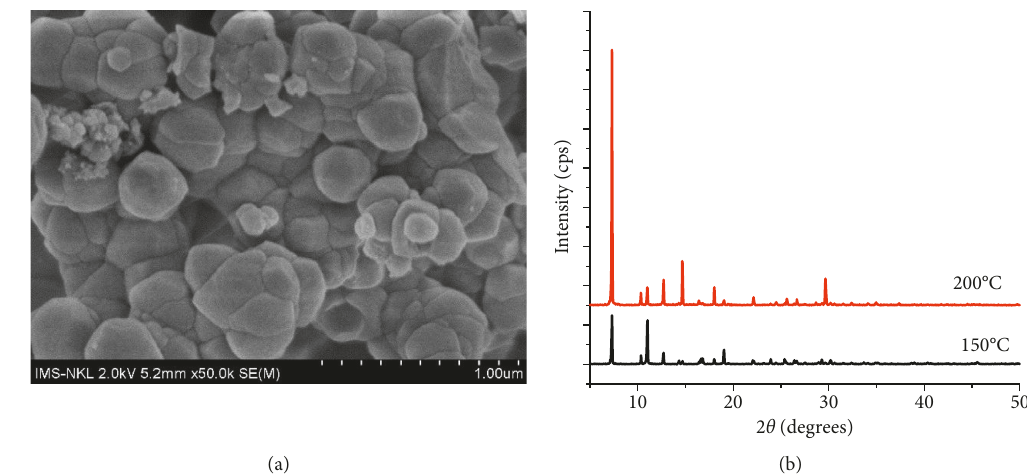
Figure 8: SEM image (a) and XRD patterns (b) of ZIF-8 samples synthesized with process B at different